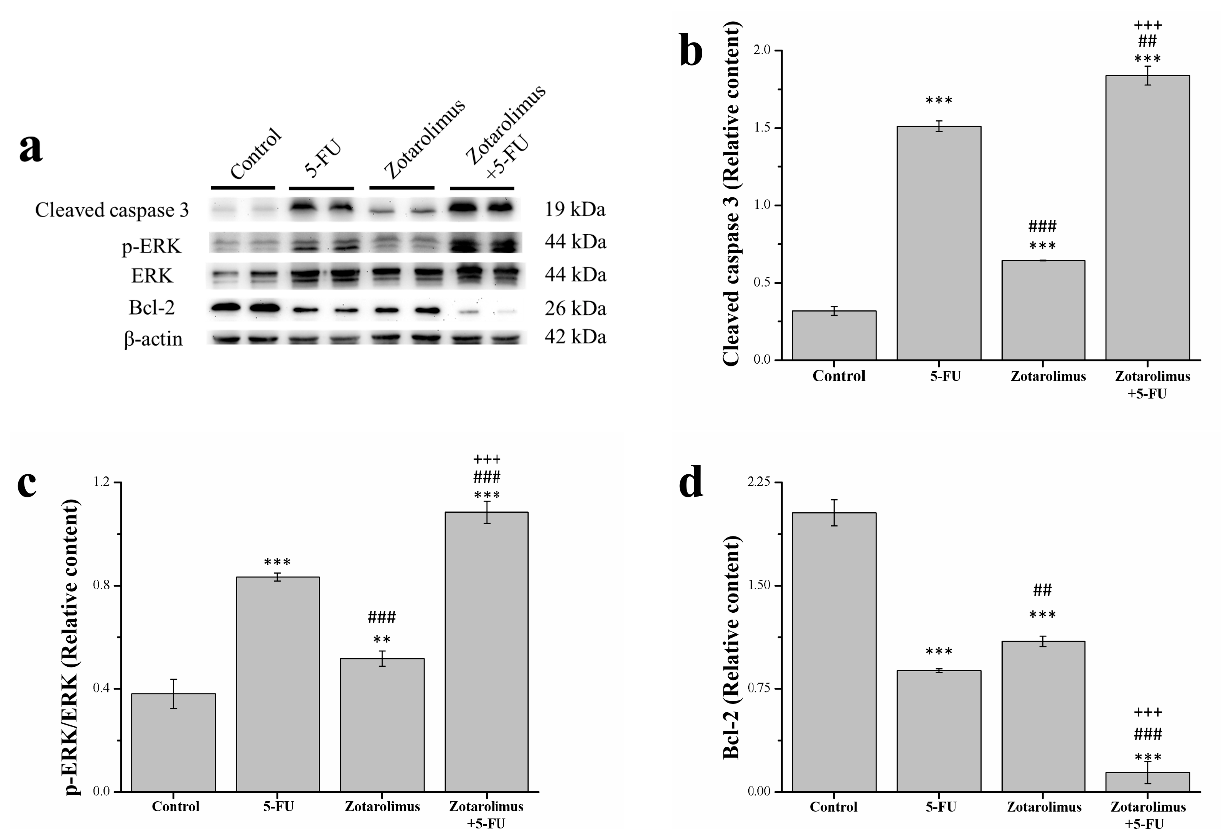
Figure 3. Analysis of apoptosis-related proteins including ( a ) a representative western blot showing the levels of apoptosis-related proteins extracted from the tumors; ( b ) cleaved caspase 3 expression; ( c ) ERK phosphorylation; and ( d ) Bcl-2 expression in the A549 tumor masses taken from BALB/cByJNarl control mice and mice given different treatments: 5-FU (100 mg/kg/week), zotarolimus (2 mg/kg/day), and zotarolimus (2 mg/kg/day) combined with 5-FU (100 mg/kg/week). All data are presented as mean ± standard deviation, n = 7 per group. ** p < 0.01 and *** p < 0.001 compared with the control group. ## p < 0.01 and ### p < 0.001 compared with the 5-FU-treated group. +++ p < 0.001 compared with the zotarolimus-treated group.